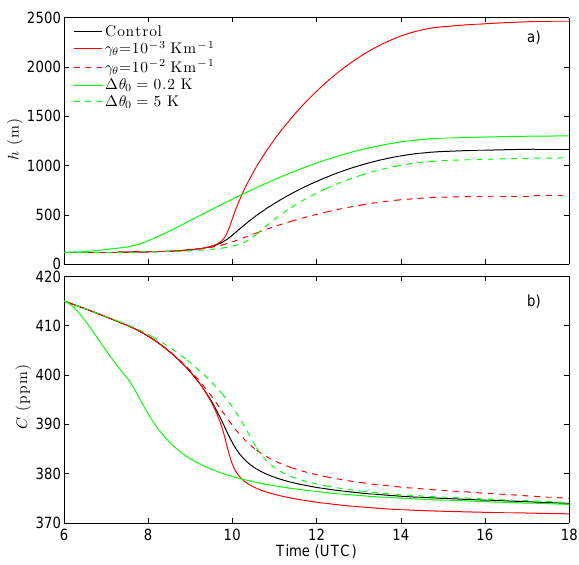
Fig.3. Timeevolutionof(a)theboundarylayerdepthand(b)theCO 2 mixingratioobtainedwiththemixedlayermodelfordifferentvalues Fig. 3. Time evolution of (a) the boundary layer depth and of γ θ and ∆ θ 0 . Thecontrolcasehas γ θ =3 . 6 10 − 3 Km − 1 ,and ∆ θ 0 =3 . 5 K.TheothervariableshavethevaluespresentedinTable1. In thefigurelegend,ifthepotentialtemperaturelapserateorinversionstrengthisnotshown,thevalueforthecontrolcaseapplies. (b) the CO 2 mixing ratio obtained with the mixed layer model for different values of γ θ and 1θ 0 . The control case has γ θ = 3 . 6 × 10 − 3 Km − 1 , and 1θ 0 = 3 . 5 K. The other variables have the values presented in Table 1. In the figure legend, if the potential temperature lapse rate or inversion strength is not shown, the value for the control case